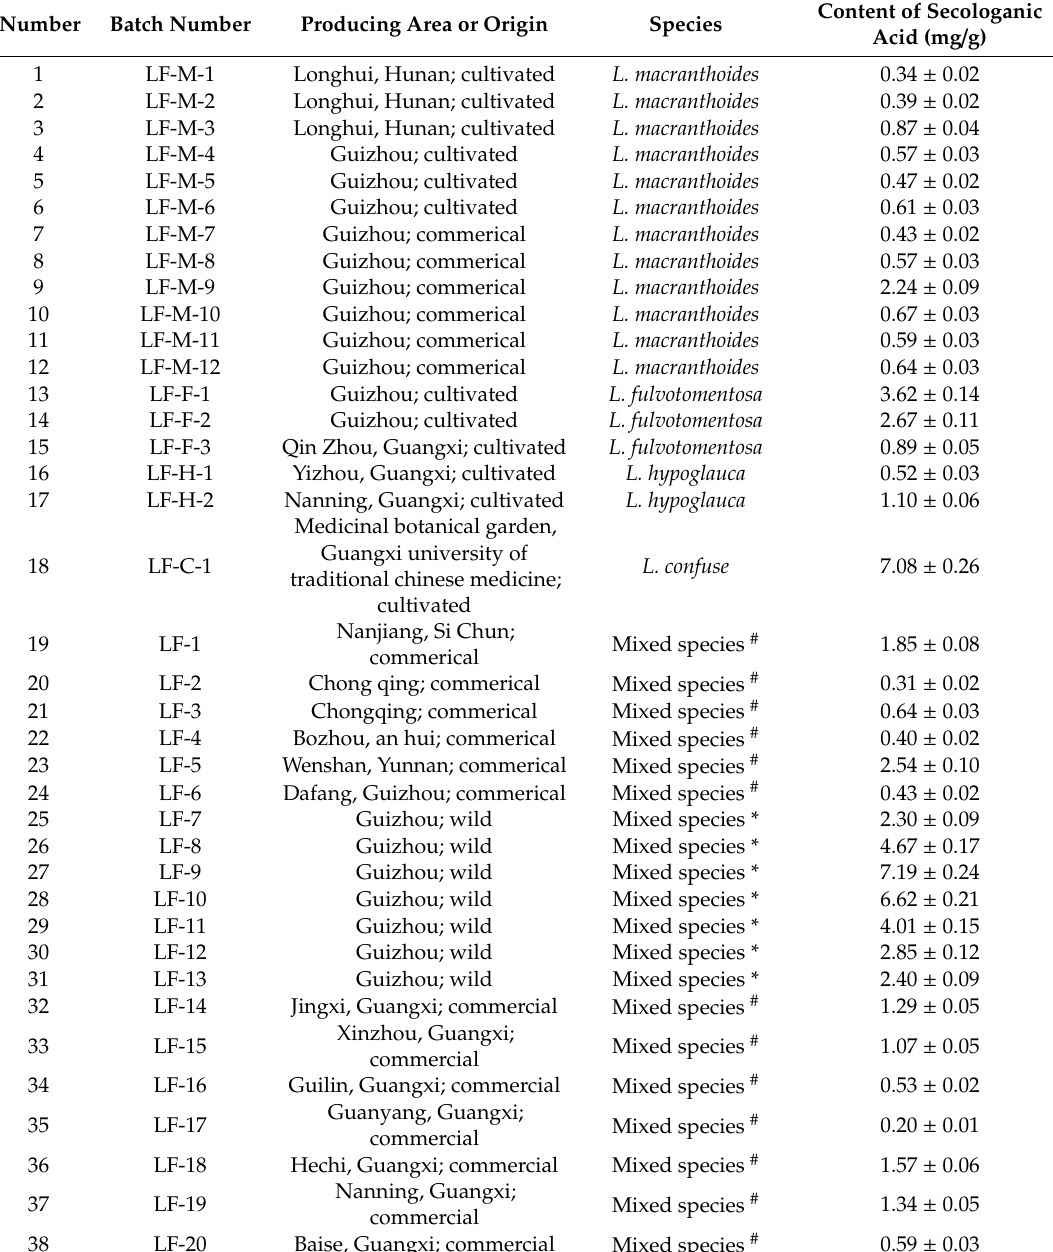
Table 2. Contents of secologanic acid in samples of LF ( n = 3, x ±